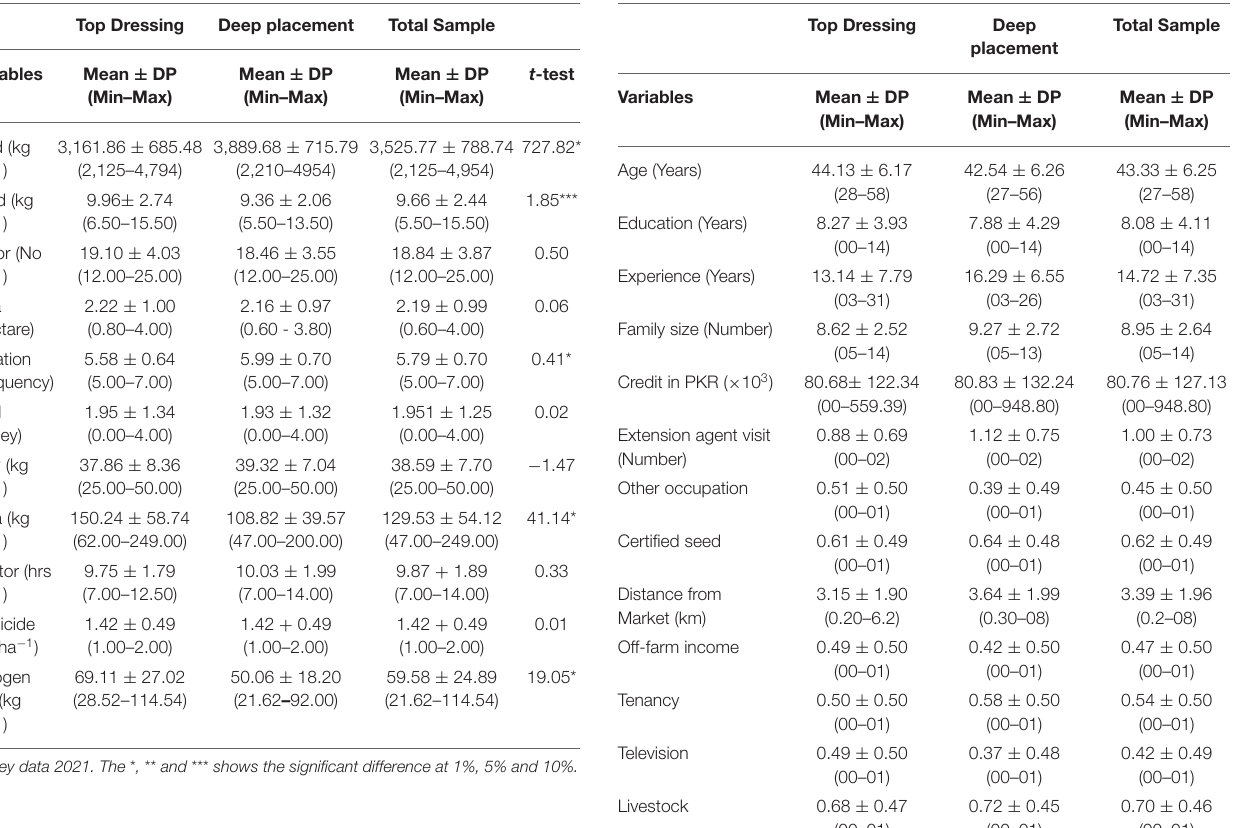
TABLE 1 | Descriptive statistic of major variables used in the SFA